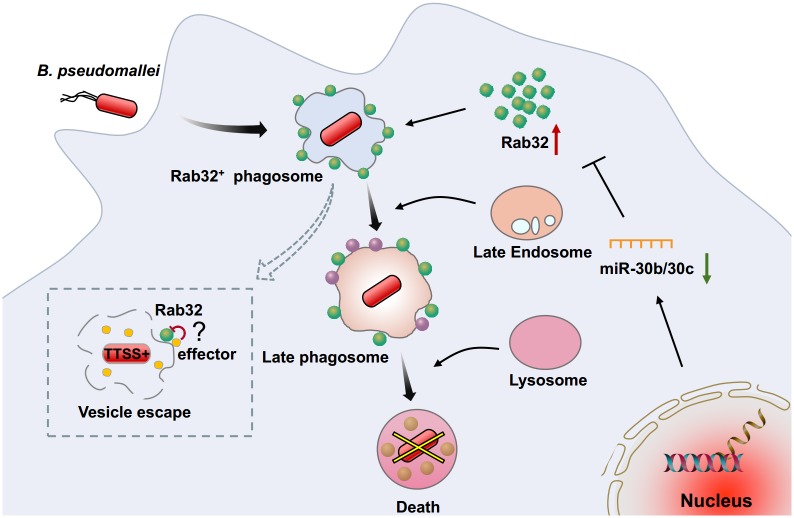
Schematic representation of Rab32 in the control of Burkholderia pseudomallei intracellular growth by macrophages.After internalization into macrophages, host cell responds to B. pseudomallei infection by downregulating the expression of miR-30b/30c, which results in an increase in Rab32 expression. Subsequently, Rab32 is recruited to the B. pseudomallei-containing phagosomes and promotes the transport to late endocytic compartment. Finally, Rab32 accelerates the B. pseudomallei-containing phagosomes trafficking to the lysosomal compartment with degradative activity. Additionally, a portion of B. pseudomallei can escape from the Rab32-positive phagosome into the cytosol in a process which is largely uncharacterized but likely involves the TTSS.